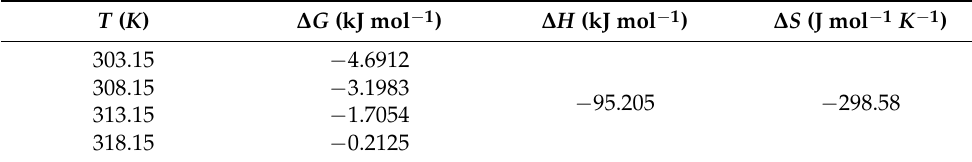
Table 4. Thermodynamic parameters for RO 16 adsorption on